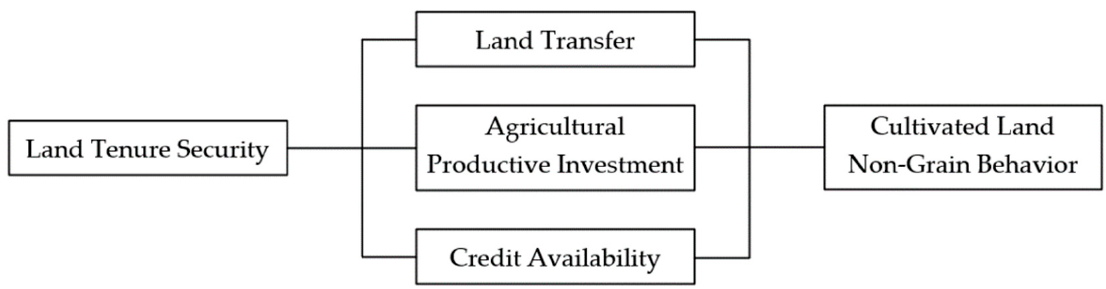
Figure 1. Analysis framework.